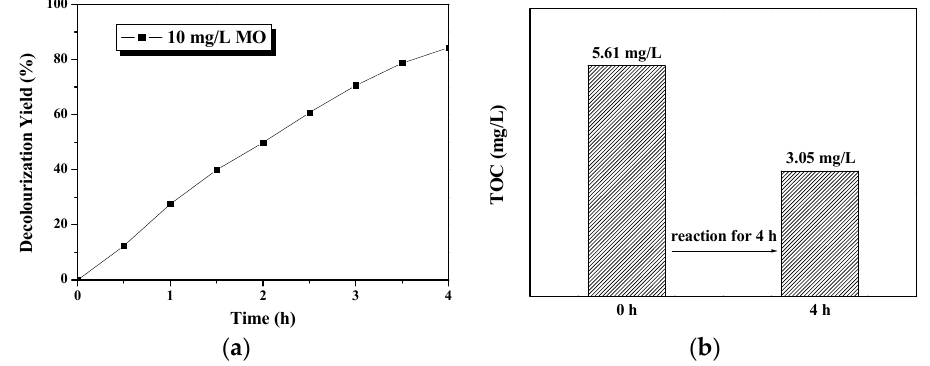
Figure 6. Photocatalytic activity test for methyl orange (MO). Reaction conditions: 45 mL of 10 mg/L MO as degradation target, 7 W ultraviolet (UV) lamp as light source, TiO 2 nanowire photocatalyst deposited on 0.2-mm substrate with 20 mm × 20 mm active area immersed in the pollutant solution; the distance between light source and catalytic film is 20 mm. The reaction was conducted in a quartz beaker under magnetic stirring. ( a ) The line curve is decolorization yield changes with time; ( b ) the bars diagram represents the initial and final total organic carbon (TOC) value after the 4-h reaction.